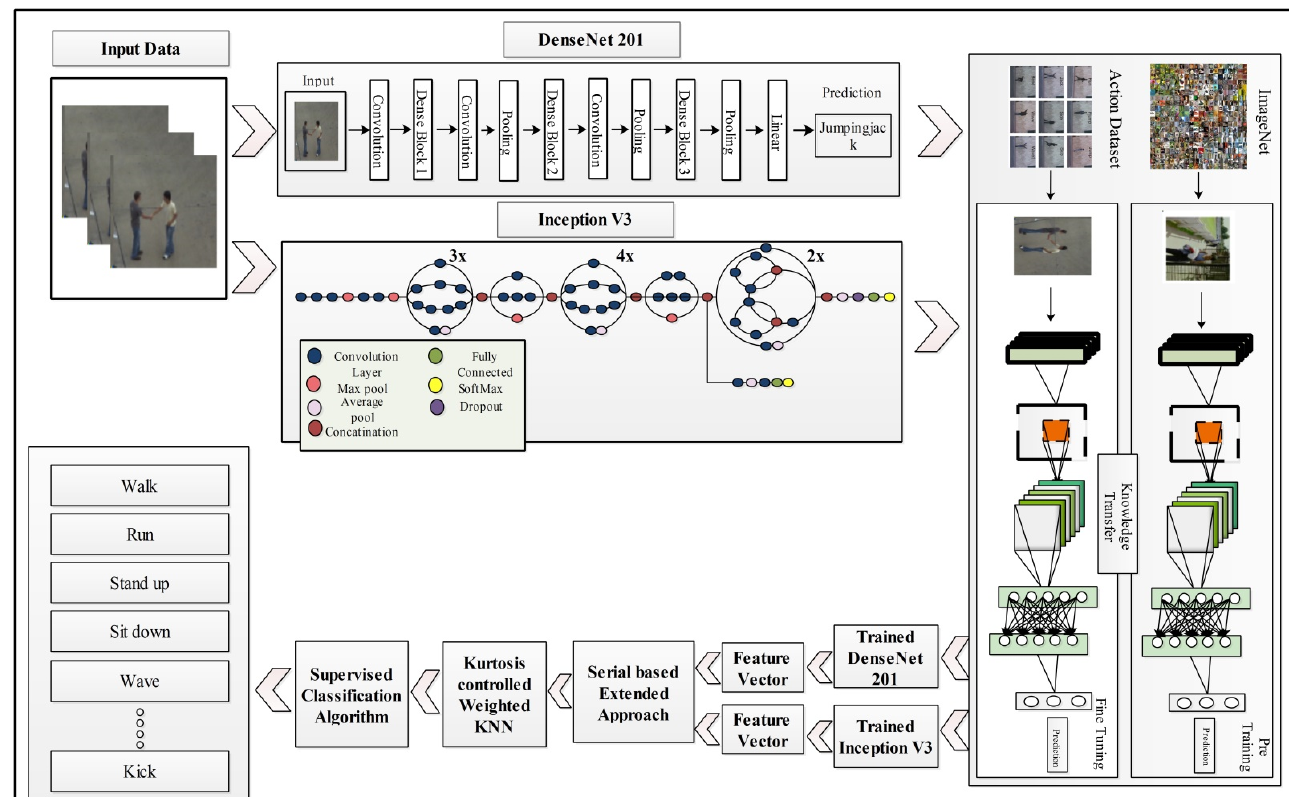
Figure 1. Illustration of a proposed design for HAR using deep learning.